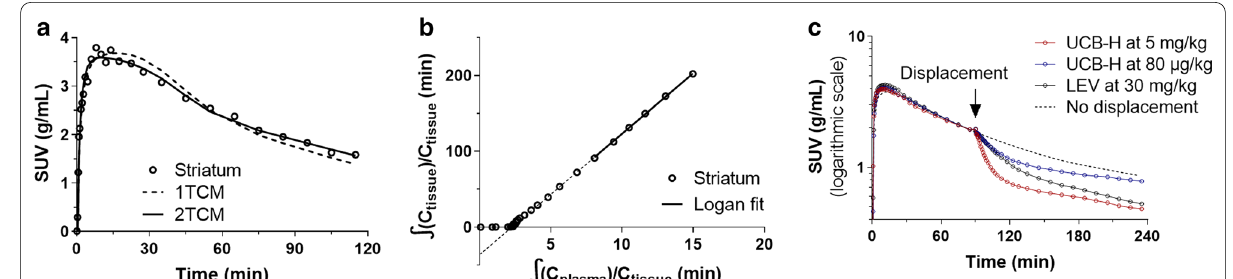
Fig. 3 a According to the lowest Akaike Information Criterion (AIC), the two-compartment model (2TCM, full line) fitted better the TACs (here striatum, circles) compared to the one-compartment model (1TCM, dashed line). b Logan graphical linear fit of striatal TAC (circles) with t* fixed at 60 min. c Dose dependent displacement of [ 18 F]UCB-H at 90 min after radioligand injection by [ 19 F]UCB-H at 80 µg/kg (red) and 5 mg/kg (blue).